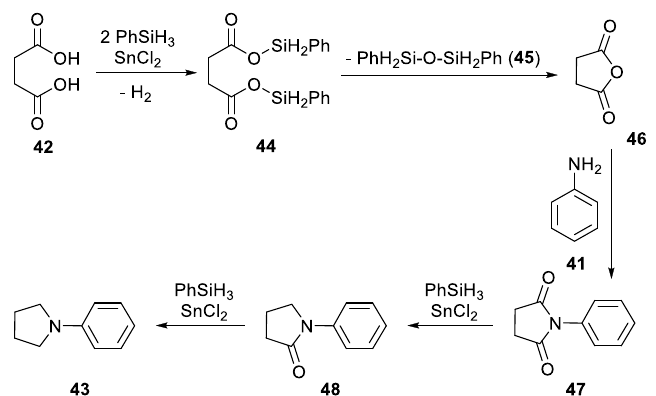
Scheme 11. Proposed reaction pathway for the reductive amination of succinic acid and